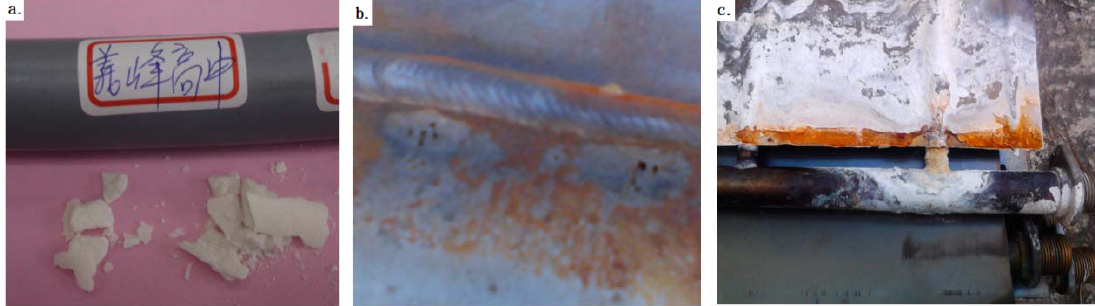
Figure 2. ( a ) Scaling in the connecting pipe; ( b ) pitting corrosion near the weld on storage tank; ( c ) corrosion and scaling on solar collector.